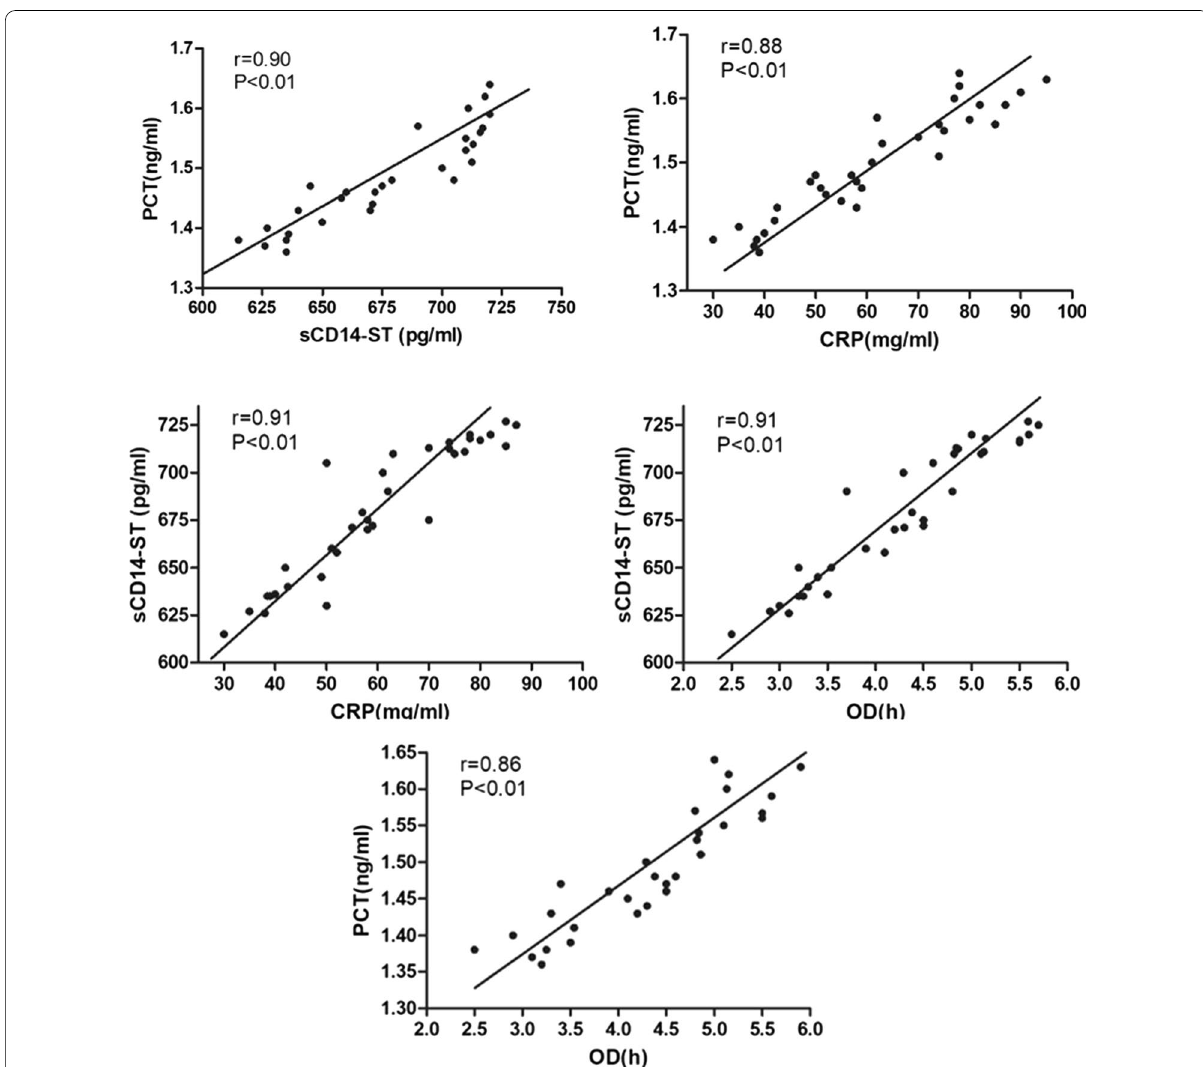
Fig. 1 Correlations among serum levels of PCT, CRP, and sCD14-ST and OD, evaluated using the Spearman rank correlation coefficient. P < 0.05